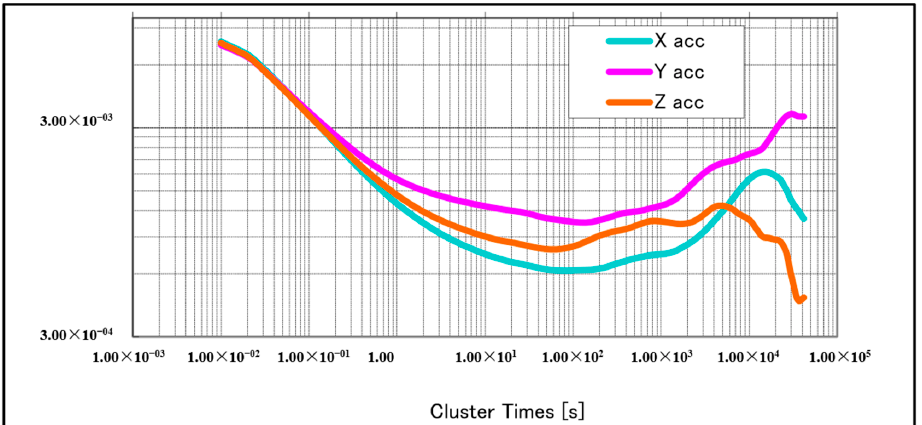
Figure 5. AV plots for accelerometers.